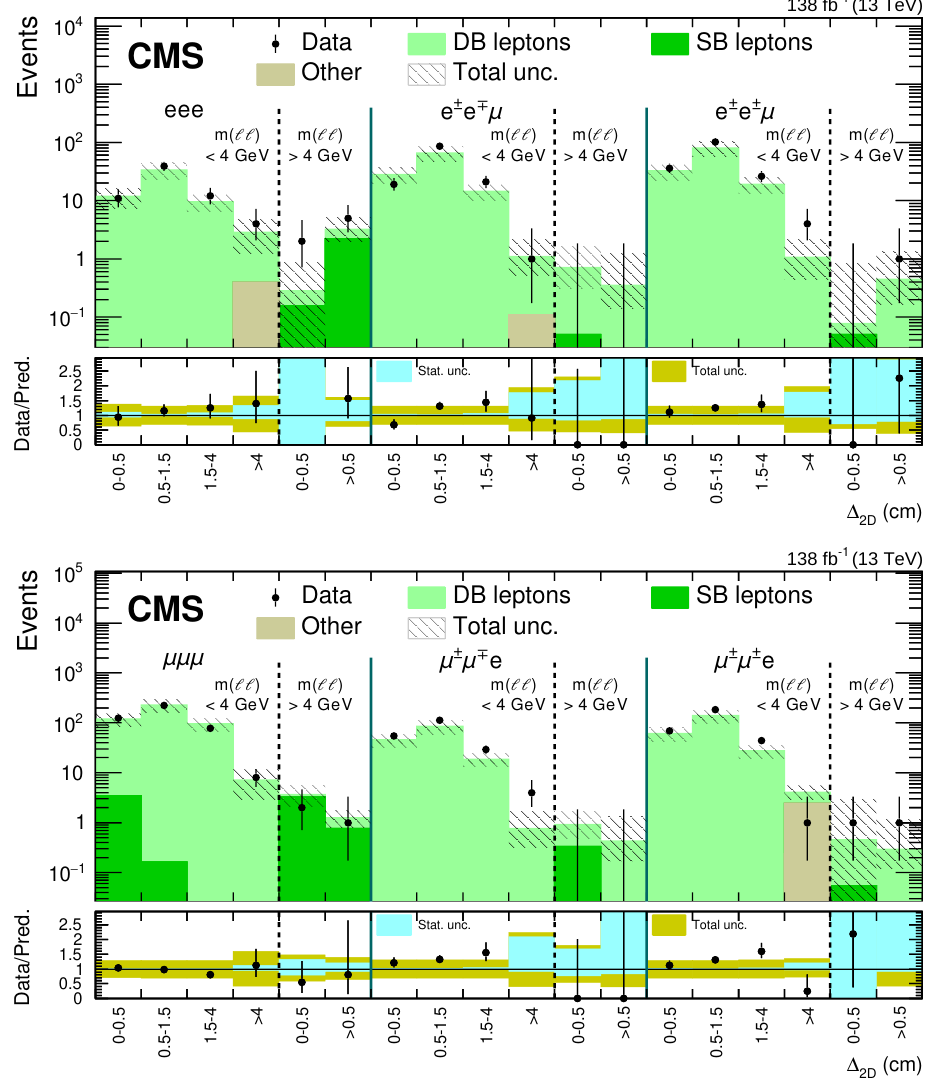
Figure 3 . Comparison between the number of observed events in data and the background predic- tions (shaded histograms, stacked) in the background validation region for eeX (upper) and mm X (lower) final states. The hashed band indicates the total systematic and statistical uncertainty in the background prediction. The lower panels indicate the ratio between data and prediction, and missing points indicate that the ratio lies outside the axis range. The uncertainty band assigned to the background prediction includes statistical and systematic contributions. Small contributions from background processes that are estimated from simulation are collectively referred to as